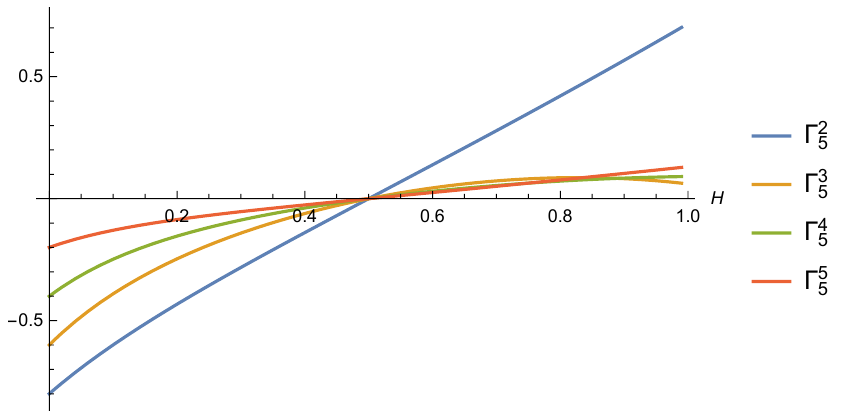
Figure 11. Case n = 5: Γ 2